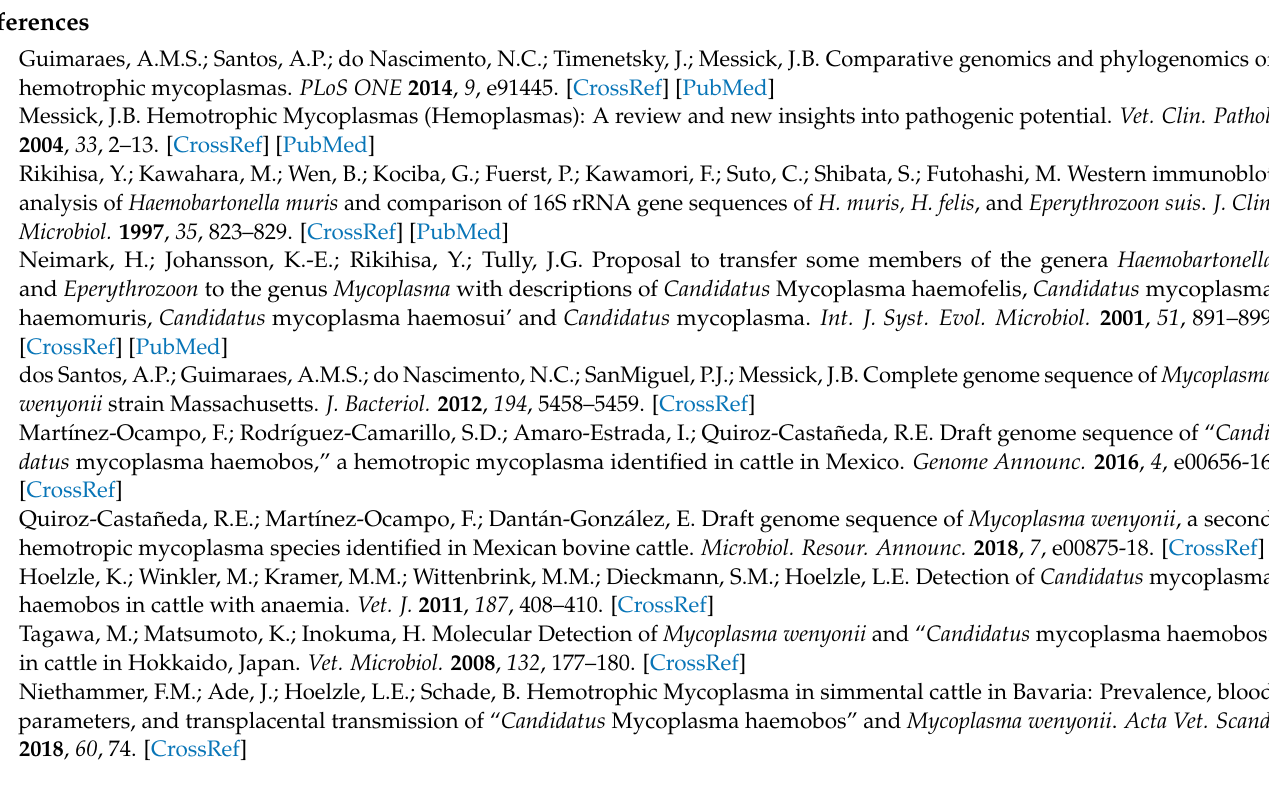
Table S1: 12 hemoplasma genomes reported in the GenBank database, Table S2: BLAST-based average nucleotide identity (ANIb) values of alignment coverage of 12 hemoplasma genomes, Table